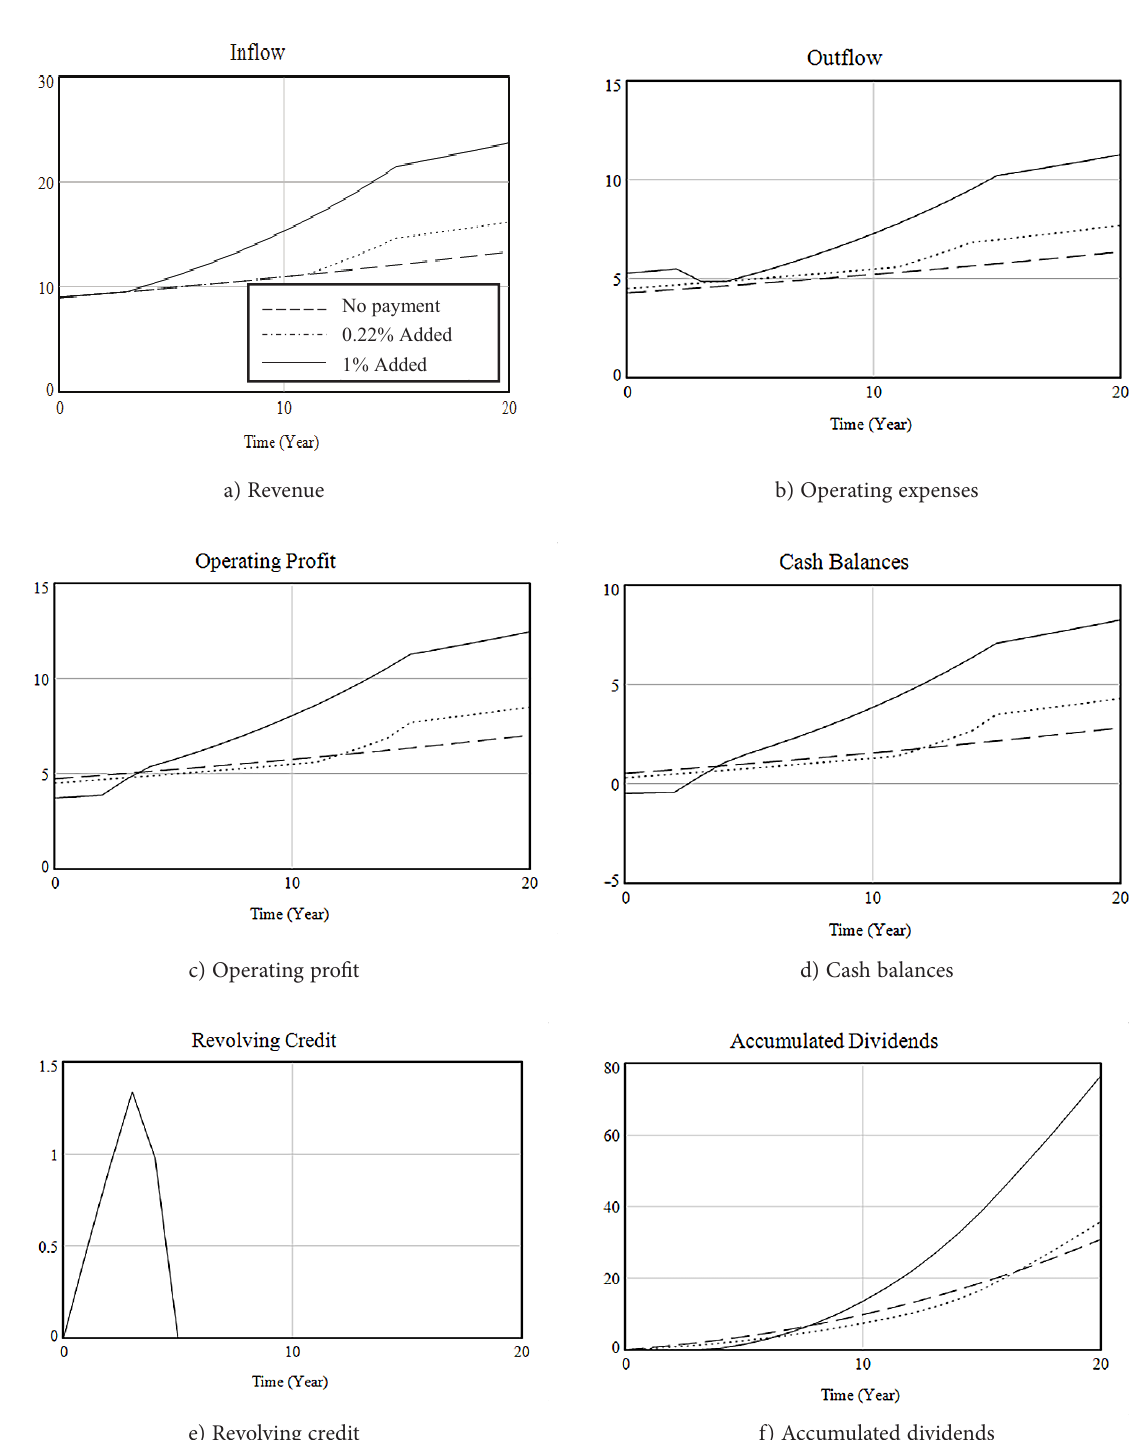
Figure 6. Simulation validation (X axis: time; Y axis: